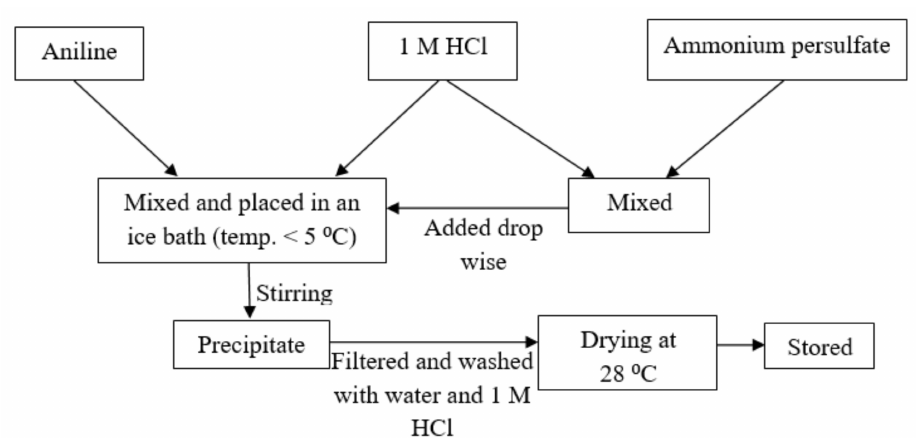
Figure 7. Flow chart of synthesis of PANI (ES) by chemical oxidation